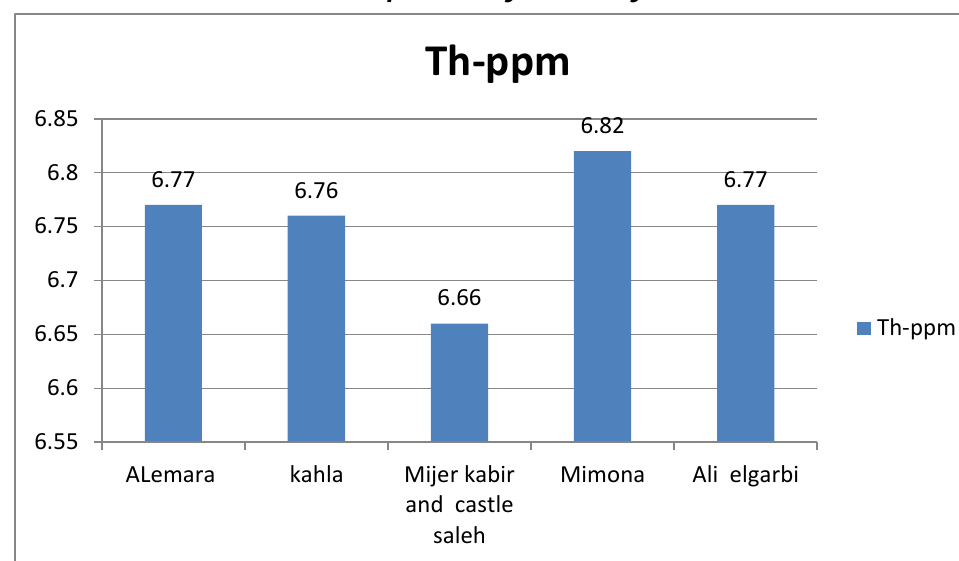
Fig. 4: The rates of concentrations of uranium isotope (U-238) for elected positions in the Missan province by GR-460 system.